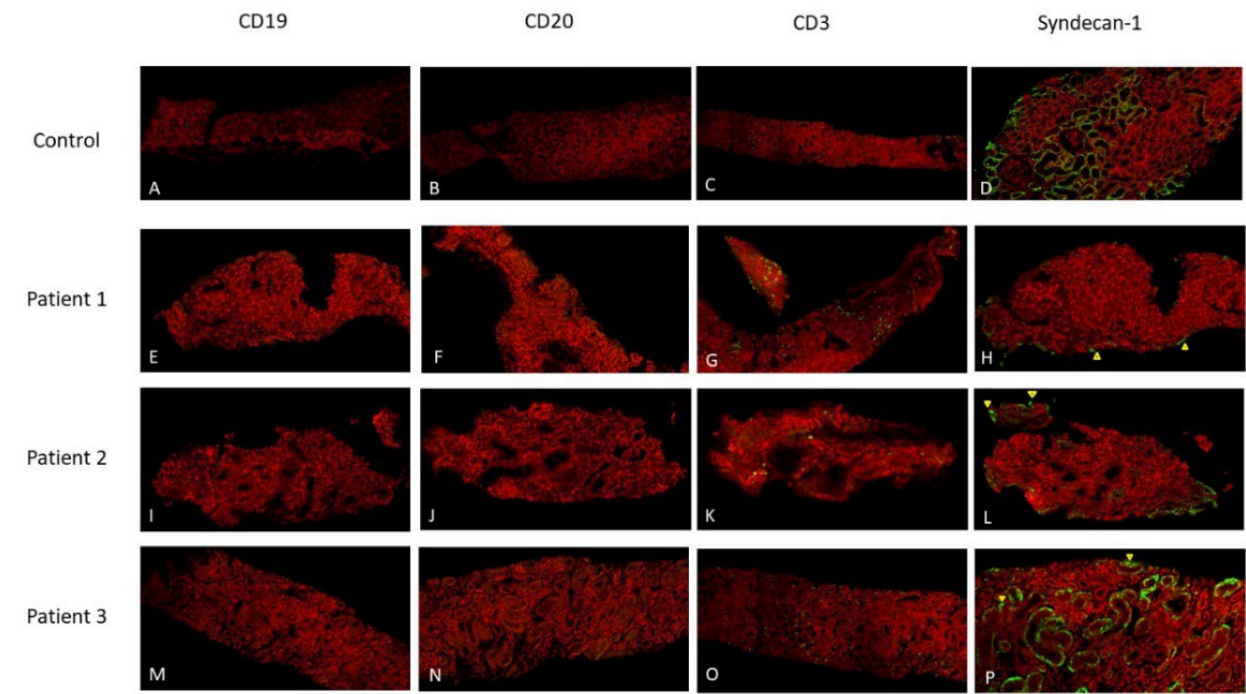
Figure 2. Immunofluorescence stains of CD19 ( A , E , I , M ), CD20 ( B , F , J , N ), CD3 ( C , G , K , O ) and Syndecan-1 ( D , H , L , P ).The positive stain showed in green color. The Syndecan-1 positive cells in interstitial space were marked as yellowish triangles. The scale bar in each subfigure indicates 100 μm.